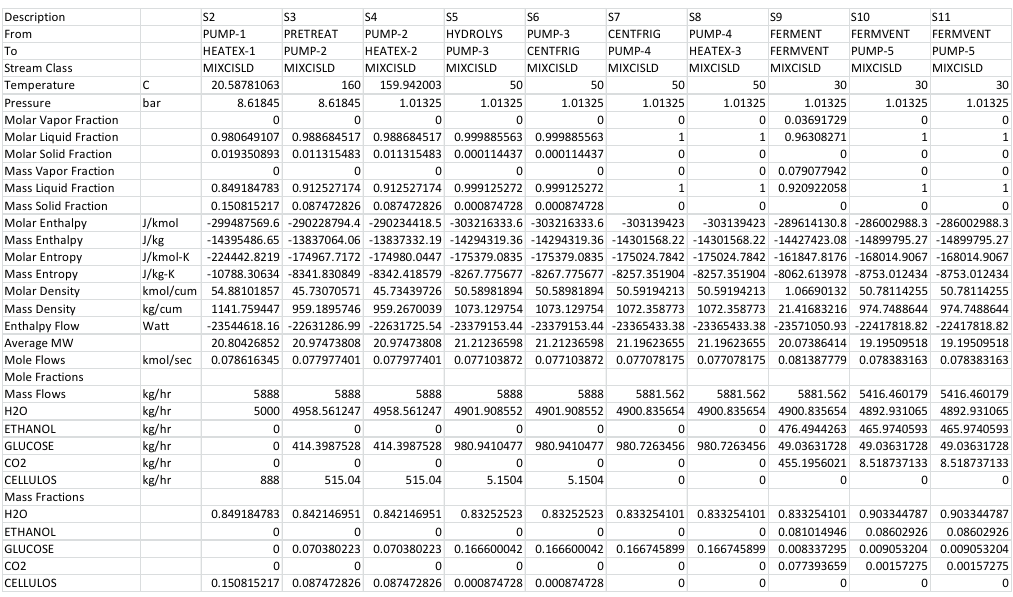
Figure A17. Fermentation stream results (part 1).